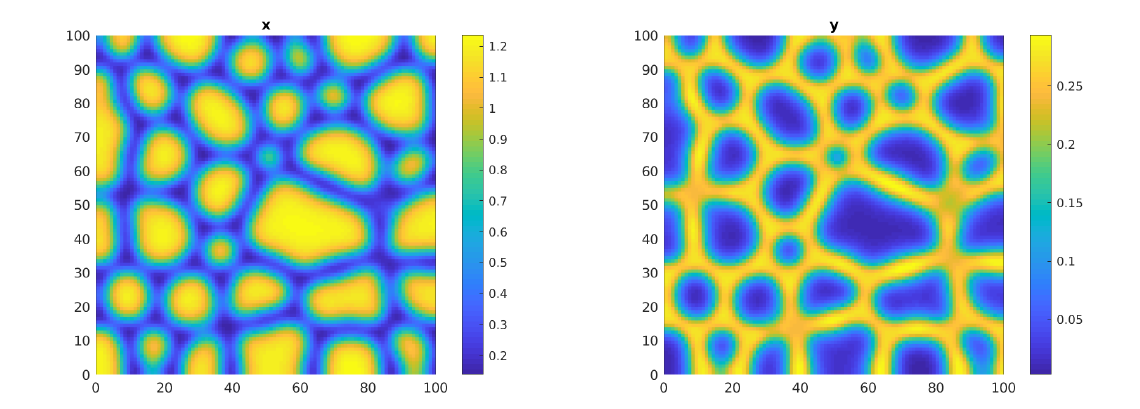
Figure 13. Plots of the solutions x ( left panel ) and y ( right panel ) of system (2)–(5) in the parameter setting of Example 4 for T = 6000. Here γ 21 = 0.3.